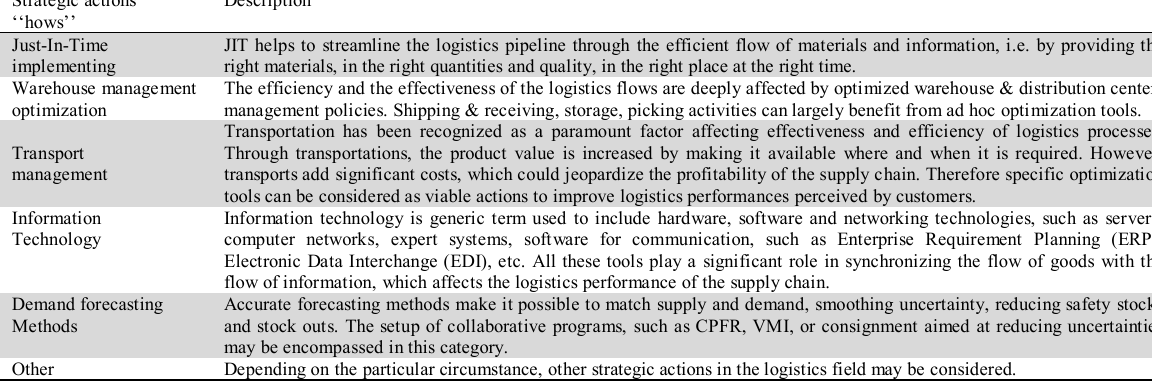
List of viable strategic actions (Bottani & Rizzi, 2005) Strategic actions ‘‘hows’’